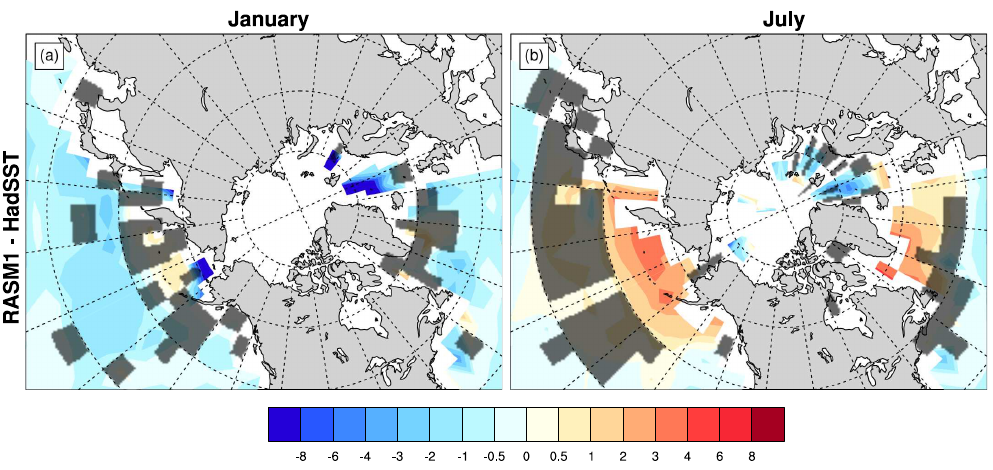
Figure 6. The bias in sea surface temperature ( ◦ C) in RASM1 from that of HadSST in (a) January and (b) July for 1990–2009. The shading indicates differences that are not statistically significant at the 95% level according to the Welch’s two-sided t test. The white grid cells are those that have missing data in